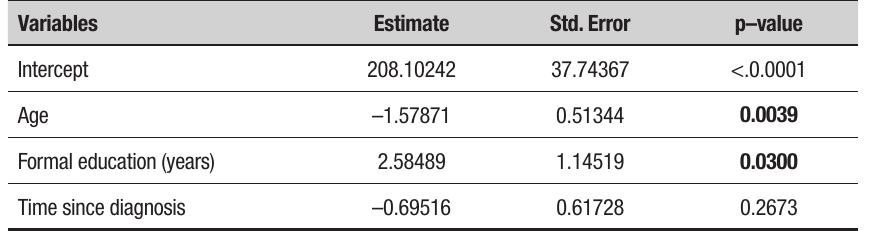
Table 4. Model of multiple linear regression for performance on